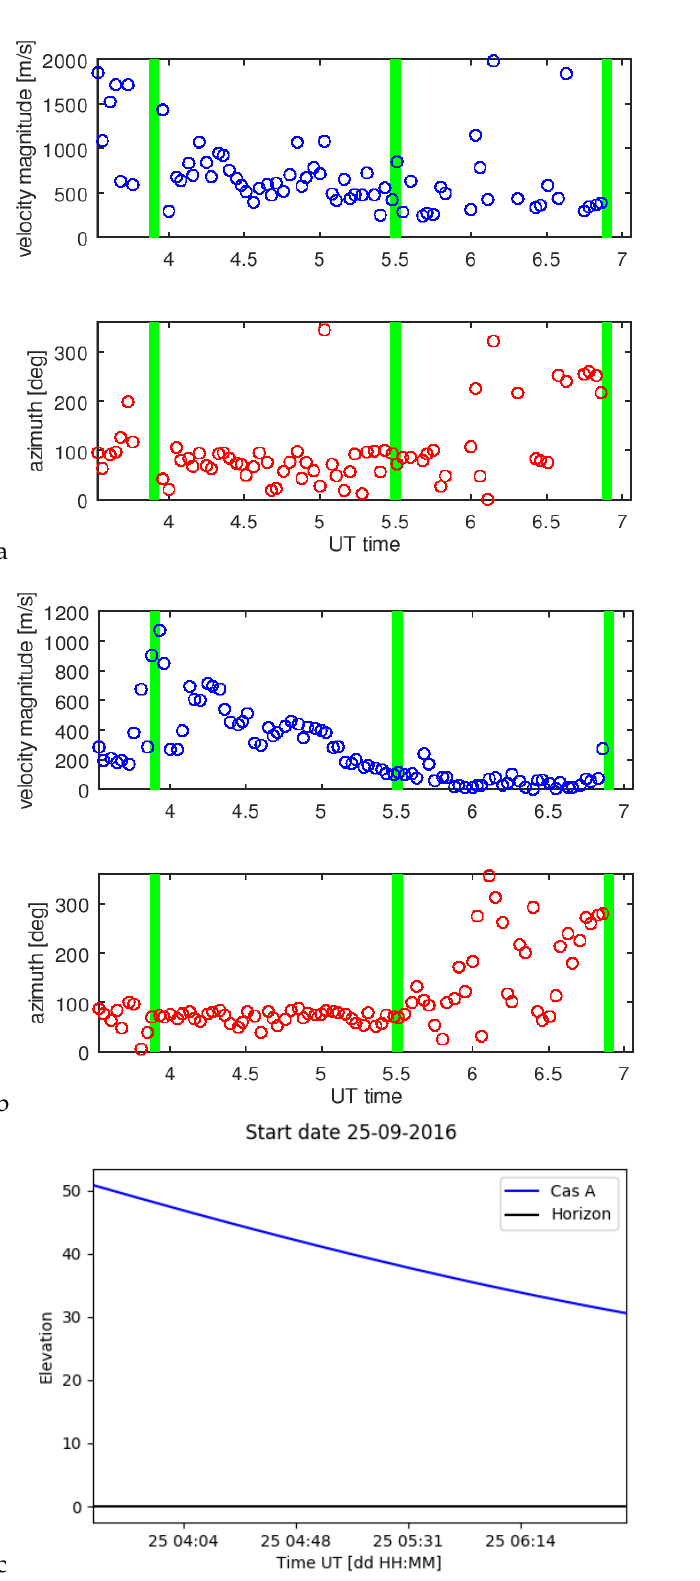
Figure 18. The drift velocity magnitude and azimuth as a function of time for the L547785 dataset for two estimators: (12)—( a ) and (20)—( b ); panel ( c ) shows the elevation of the